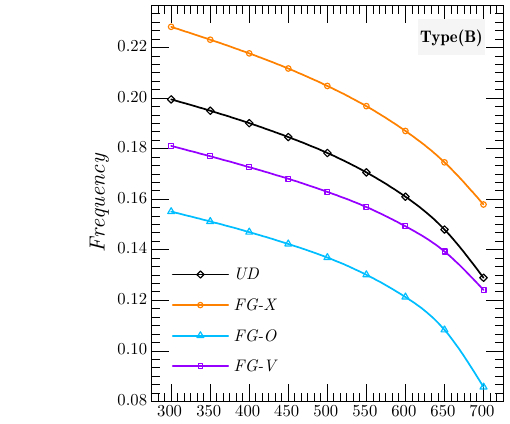
Figure 7. Effect of temperature on the dimensionless frequency of spherical CNTRC shell (cid:3435)𝑆𝑆𝑆𝑆,𝑅 (cid:3051) /𝑎 = 𝑅 (cid:3052) /𝑏 = 5,𝑁 = 10 𝑉 (cid:3030)(cid:3041)(cid:3047)∗ = 0.17,𝑝 = 1 (cid:3439) .